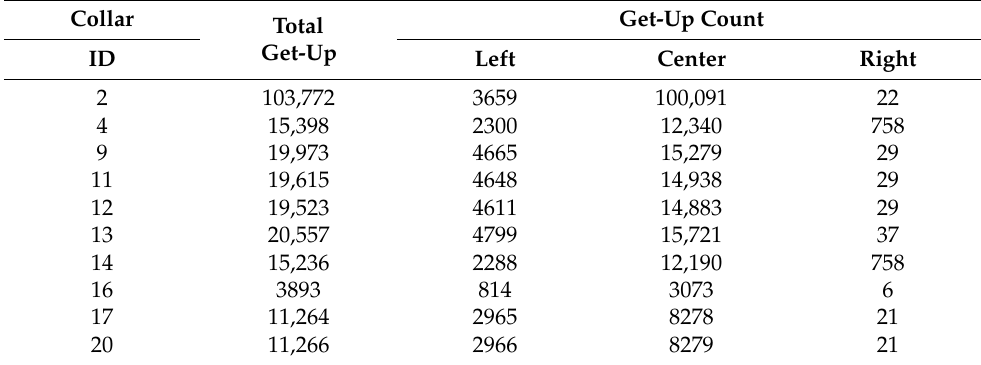
Table 1. Get-up count and get-up, lay-down, and sleep laterality